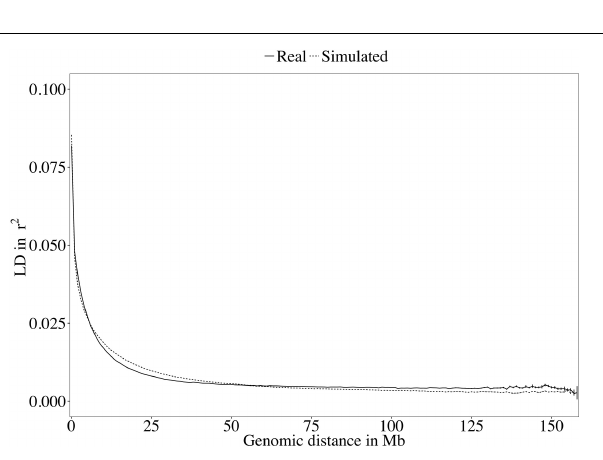
FIGURE 5 | Decay of linkage disequilibrium (LD) over genomic distance in the real and the simulated sequences.